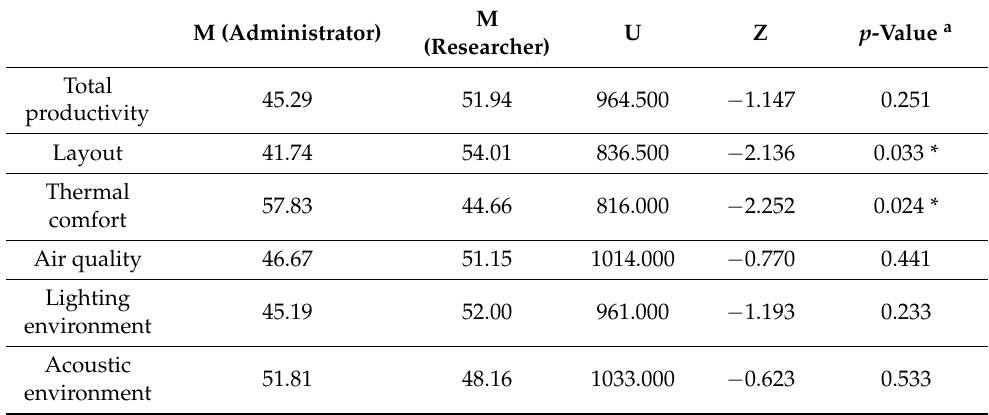
Table 8. Qualitative assessment of productivity in administrators and researchers, analyzed using the Mann–Whitney U test.